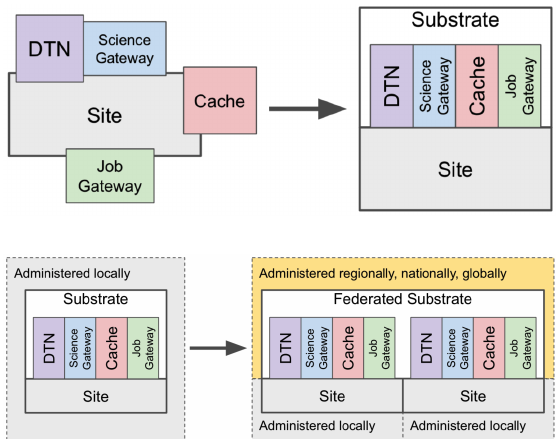
Figure 3: Top figure: individually installed edge ser- vices at a site can be deployed declaratively through use of a “substrate”. Bottom figure: federated sub- strates can be built from sites, with services sharing common declarative deployment patterns on the indi- vidual sites. Note the partionining of administrative domains between the local NoOps and central